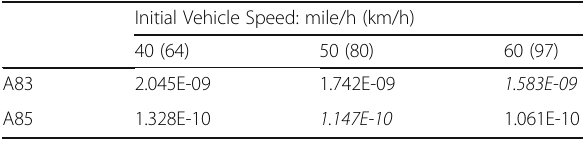
Table 1 Combined PIR for Scenarios A and B for a single trip per annum (PIR at the speed limit italicised) Initial Vehicle Speed: mile/h